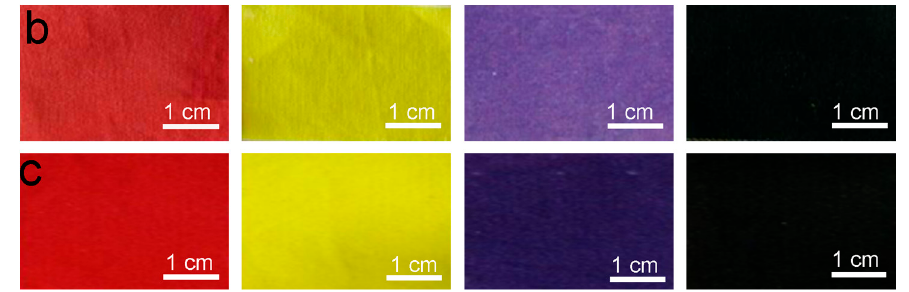
Figure 7. ( a ) K / S values on uncationized and cationized cotton with magenta, yellow, cyan, and black inks; and digital photos of uncationized ( b ) and cationized ( c ) cotton printed with magenta, yellow, cyan, and black inks.